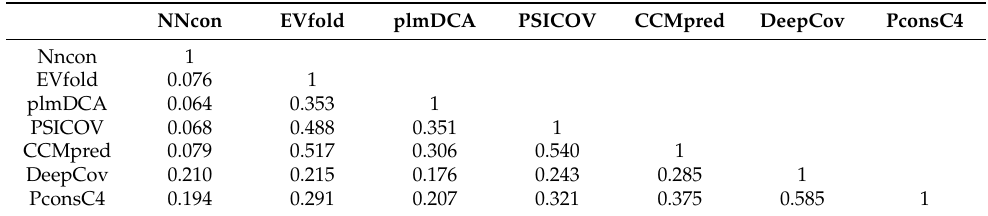
Figure 2. The weight values and the overall performance for the training set. ( A ) The weight values of PconsC4, DeepCov, CCMpred, EVfold, plmDCA, PSICOV, and NNcon with the variation of the sample size. ( B ) The average accuracy, coverage, specificity, and MCC of COMTOP at different sample sizes. Table 1. Jaccard’s similarity coefficient based on training dataset of seven